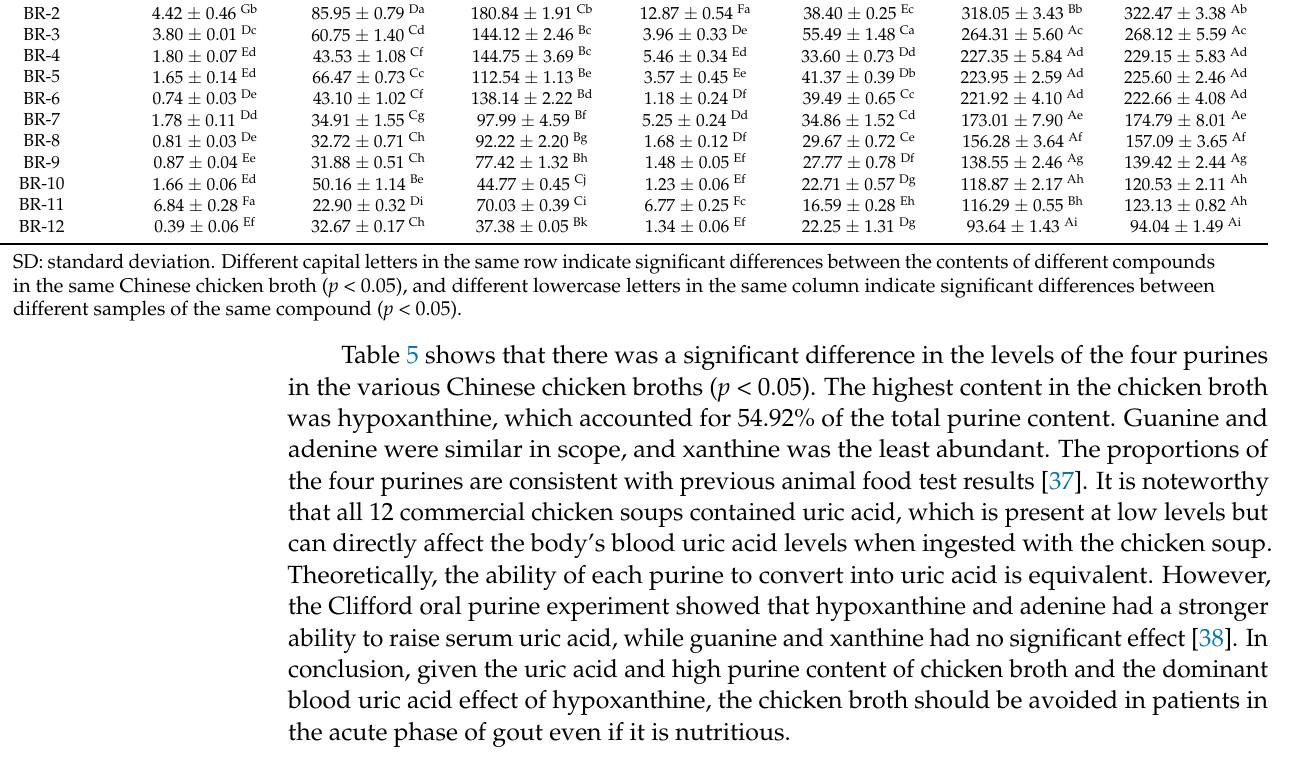
Table 5. Quantitative results of the determination of purines and uric acid in commercial Chinese chicken broths ( n = 3). Sample Uric Acid (mg/L)